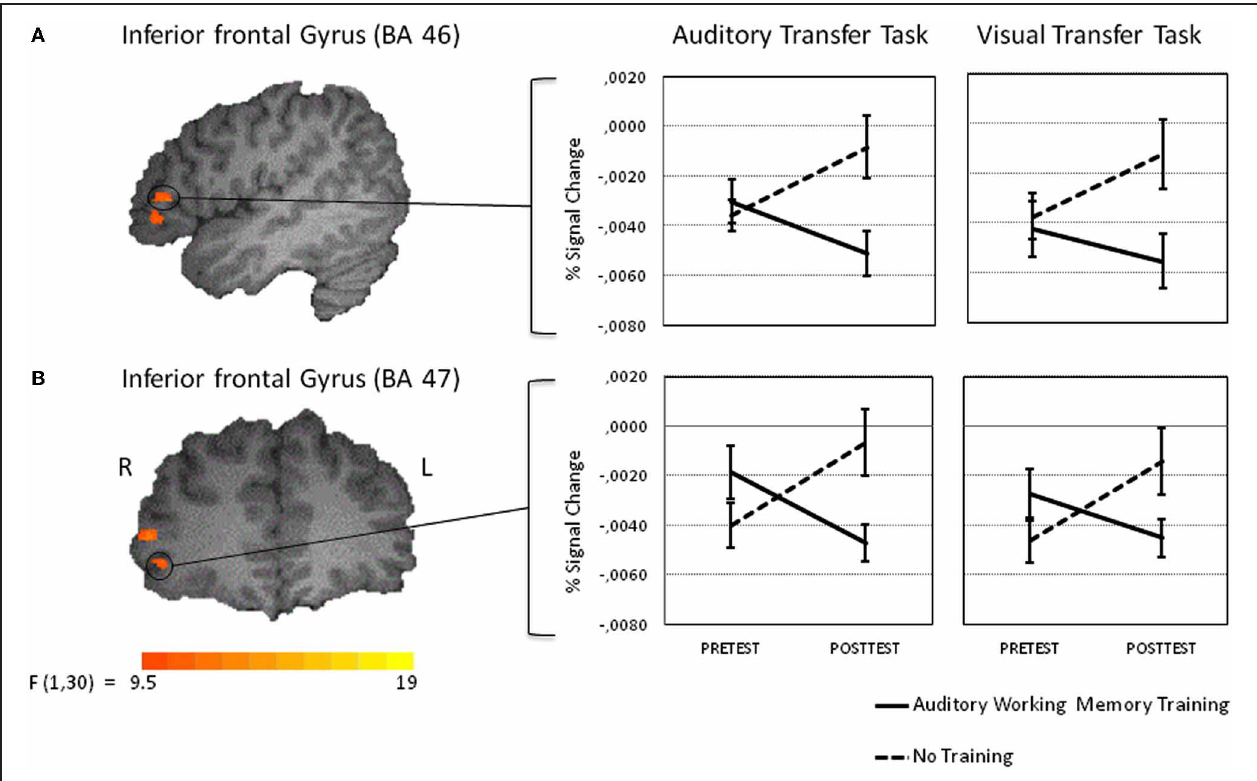
and the control groups [left inferior frontal gyrus at BA 46 ( A upper panel) and left inferior frontal gyrus at BA 47 ( B lower panel)]. Note that the activation decrease in the training group from pre to posttest was larger in the auditory than in the visual transfer task. See results section for details.